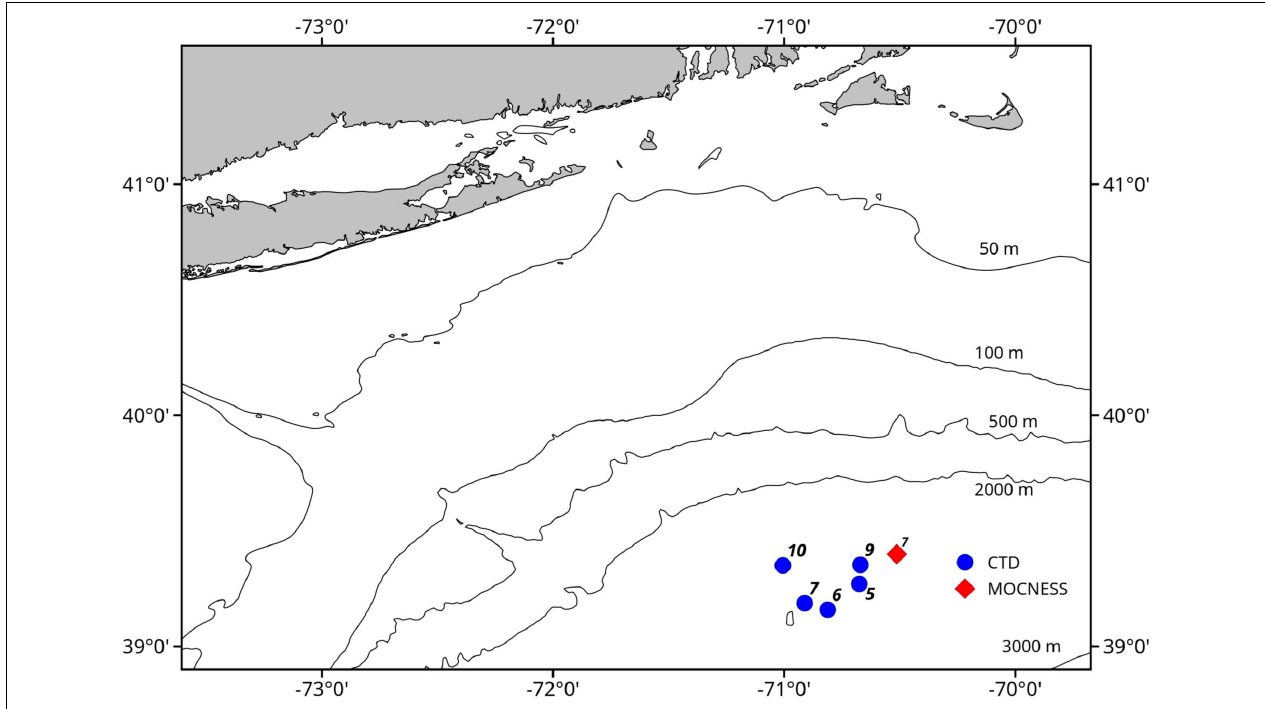
FIGURE 1 | Map of study area. Blue circles indicate locations of the CTD casts that sampled eDNA and the red diamond indicates the location of the MOCNESS